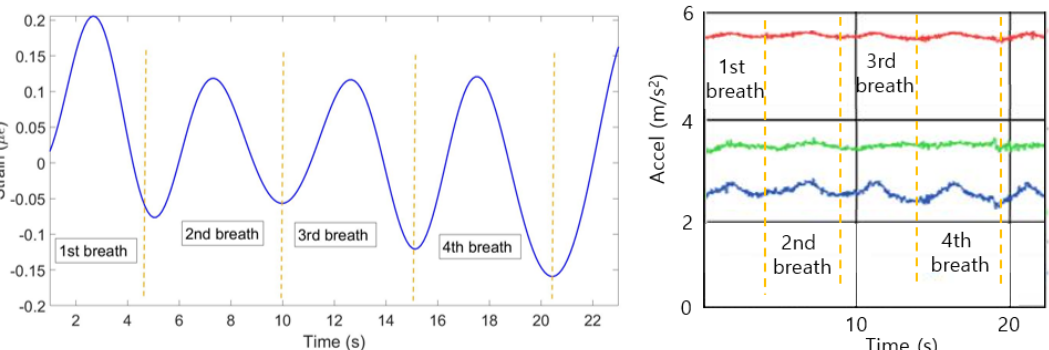
Figure 21. Breathing pattern for the second volunteer in the lying position reconstructed based on the 10 FBGs strain patterns ( left ) and obtained from the reference sensor ( right